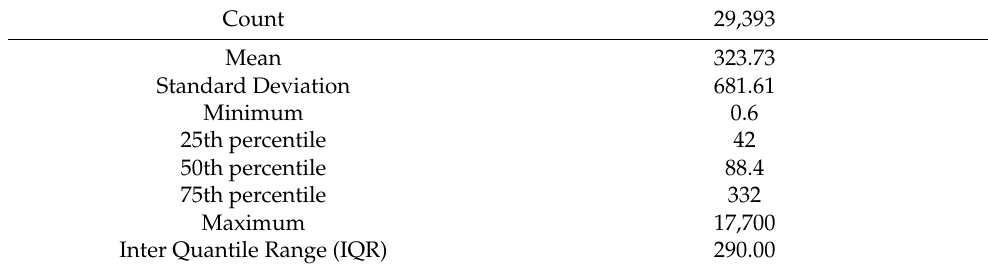
Table 1. Descriptive Statistics of the entire discharge